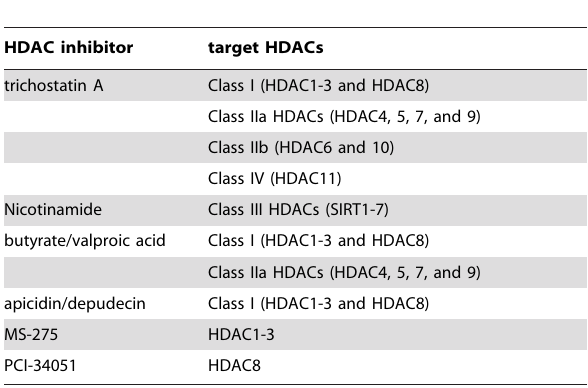
Table 1. Specificity of HDAC